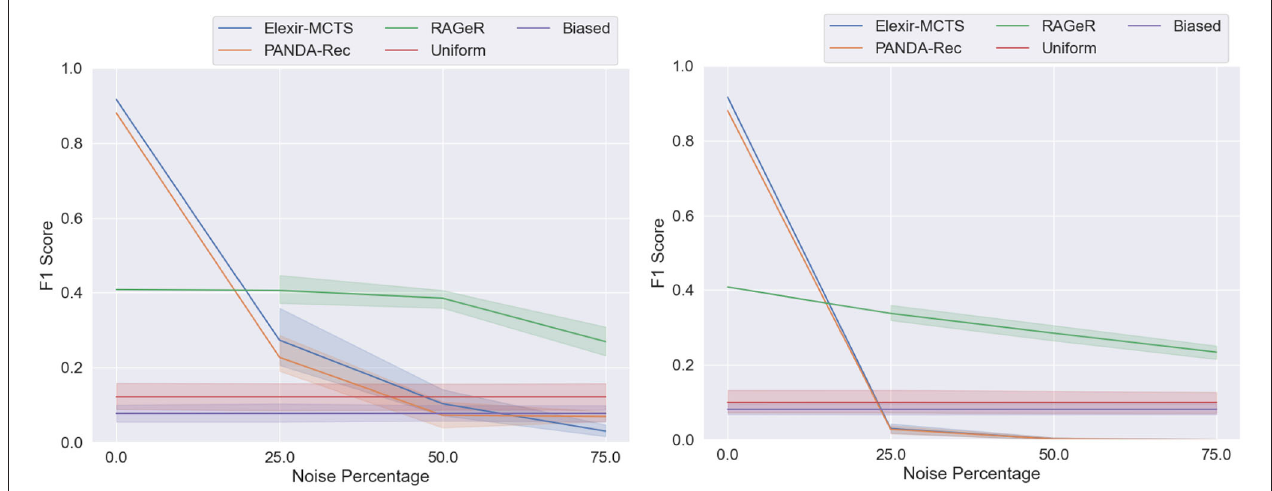
FIGURE 9 | Performance of PANDA-Rec, Elexir-MCTS, RAGeR, and two baselines (Random Uniform and Random Biased Recognition) over unreliable traces from the Monroe domain. Figures represent performance of methods with regards to unreliability resulting from missing actions (left) and incorrect actions (right) . We varied the noise percentage from 0 to 75% in increments of 25%, and all methods were run for 5 (missing actions) or 10 (incorrect actions) runs for each noise percentage (excluding 0% noise). Each lines represent a 95% confidence interval for the average macro F1 scores over the 5 or 10